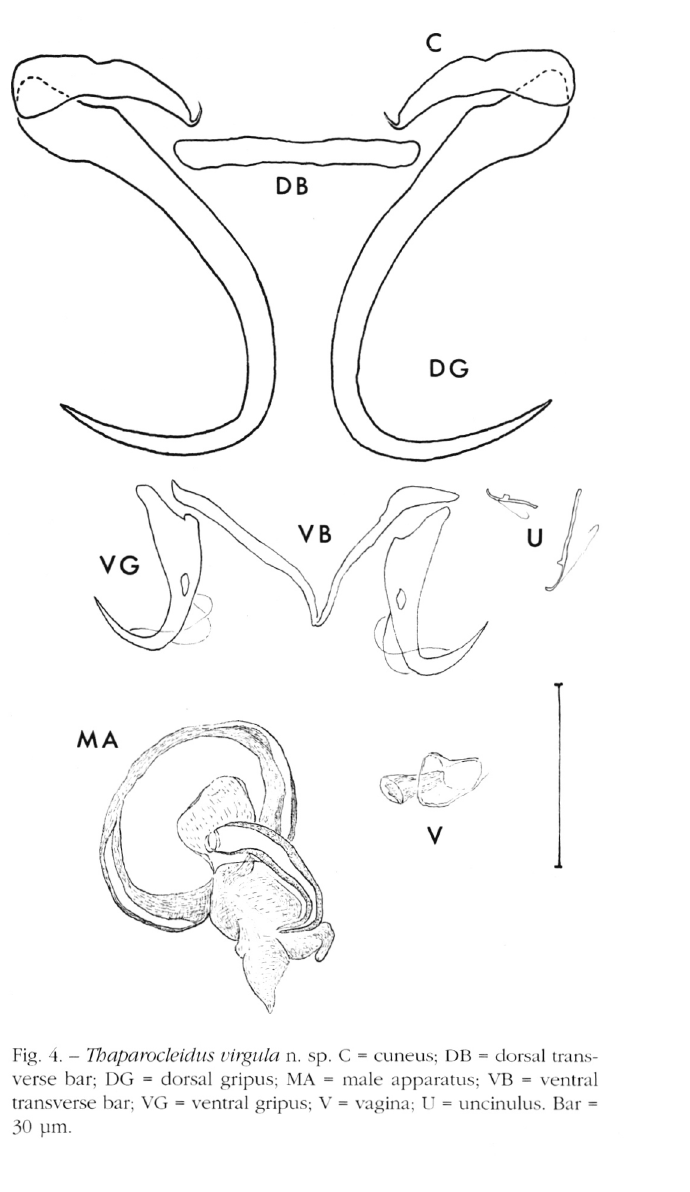
Material studied: 22